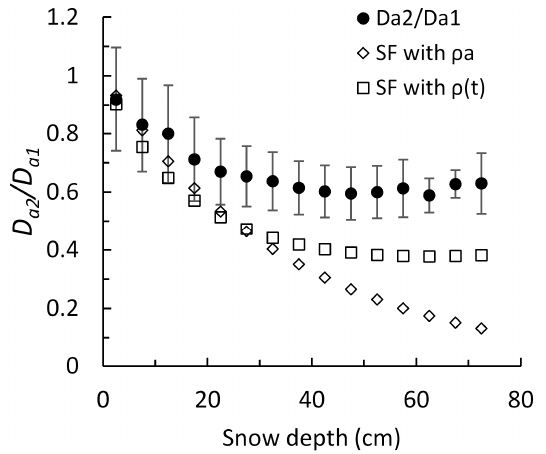
Figure 8. Relation between snow depth and the average ratio of the air dose rate after snowfall to that before snowfall in the ARM and SF obtained using two approaches.